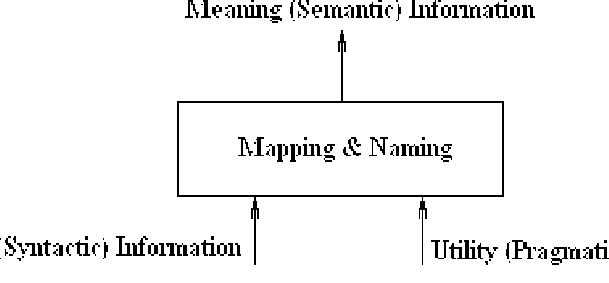
Figure 2. The interrelations among the form, utility and meaning.